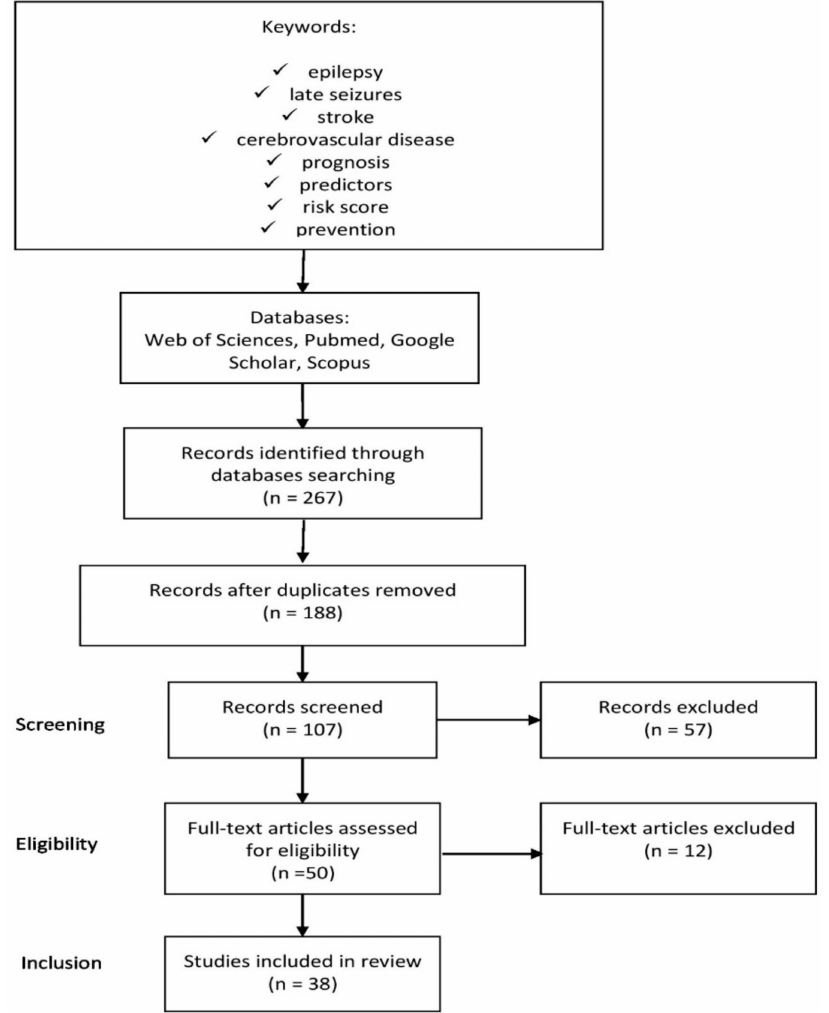
Figure 1. Diagram showing the process of selecting the appropriate